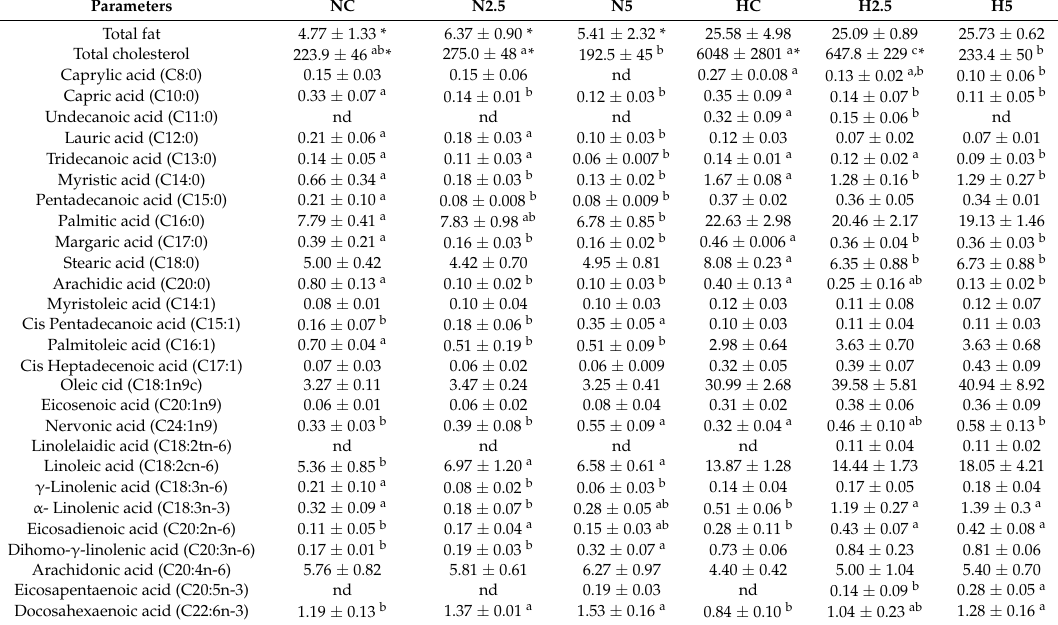
1 Data are expressed as mean ± SD. a–c Different letters show significant statistical differences ( p < 0.05) among groups fed the standard diet (NC, N2.5, N5) or the high fat diet (HC, H2.5, H5), after performing a one-way ANOVA. nd: Not detected. * Significant statistical difference ( p < 0.05), after carrying out a two-sample t test, between the Int. J. Mol. Sci. 2019 , 20 , x FOR PEER REVIEW members of the NC-HC, N2.5-H2.5, and N5-H5 pairings.